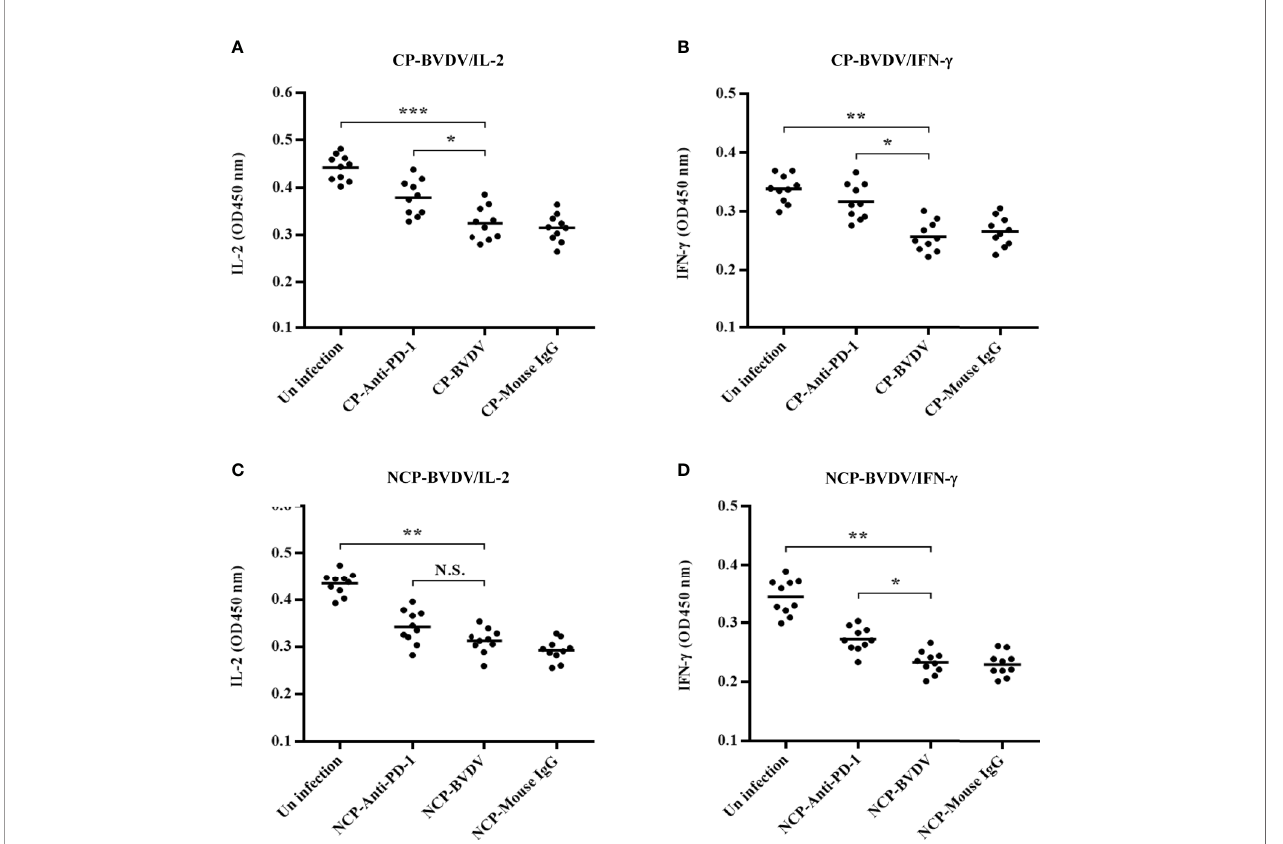
FIGURE 11 | Effect of PD-1 blockade on IL-2 and IFN- g in the serum of BVDV-infected mice at day 7 of post-infection. (A) IL-2 production in the serum of CP BVDV-infected mice. (B) IFN- g production in the serum of CP BVDV-infected mice. (C) IL-2 production in the serum of NCP BVDV-infected mice. (D) IFN- g production in the serum of NCP BVDV-infected mice. *** p < 0.001, ** p < 0.01, * p < 0.05, NS, not signi fi cant. The animals were assigned into 7 experimental groups, including the mock-infected group, CP BVDV-infected group, CP BVDV+anti-PD-1 group, CP BVDV+mouse IgG group, NCP BVDV-infected group, NCP BVDV +anti-PD-1 group, and NCP BVDV+mouse IgG group. CP and NCP BVDV-infected mice were used as the controls. Data are presented as mean ± SD (n = 10 per group) and analyzed using one-way